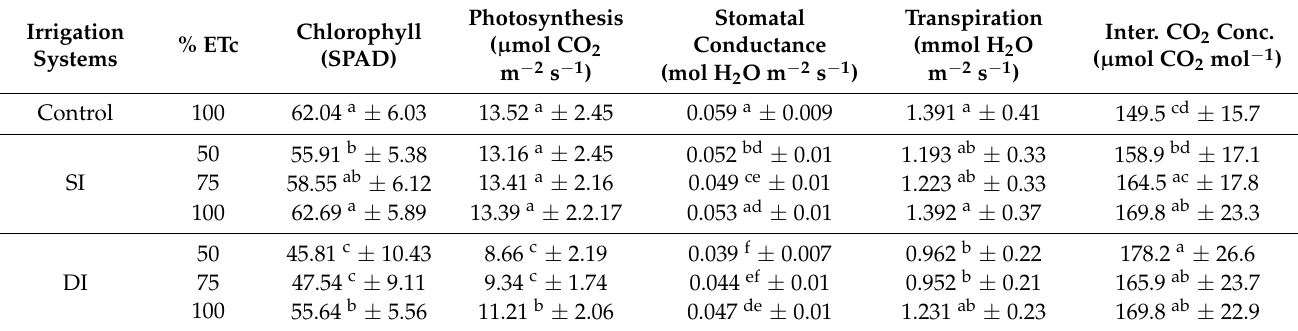
Table 3. The average values of two years of data of physiological parameters of date palm Khalas cv. under the two irrigation systems (DI and SI) at three ETc levels (50, 75, and 100%) compared with the bubbler irrigation system (control) at 100% ETc.